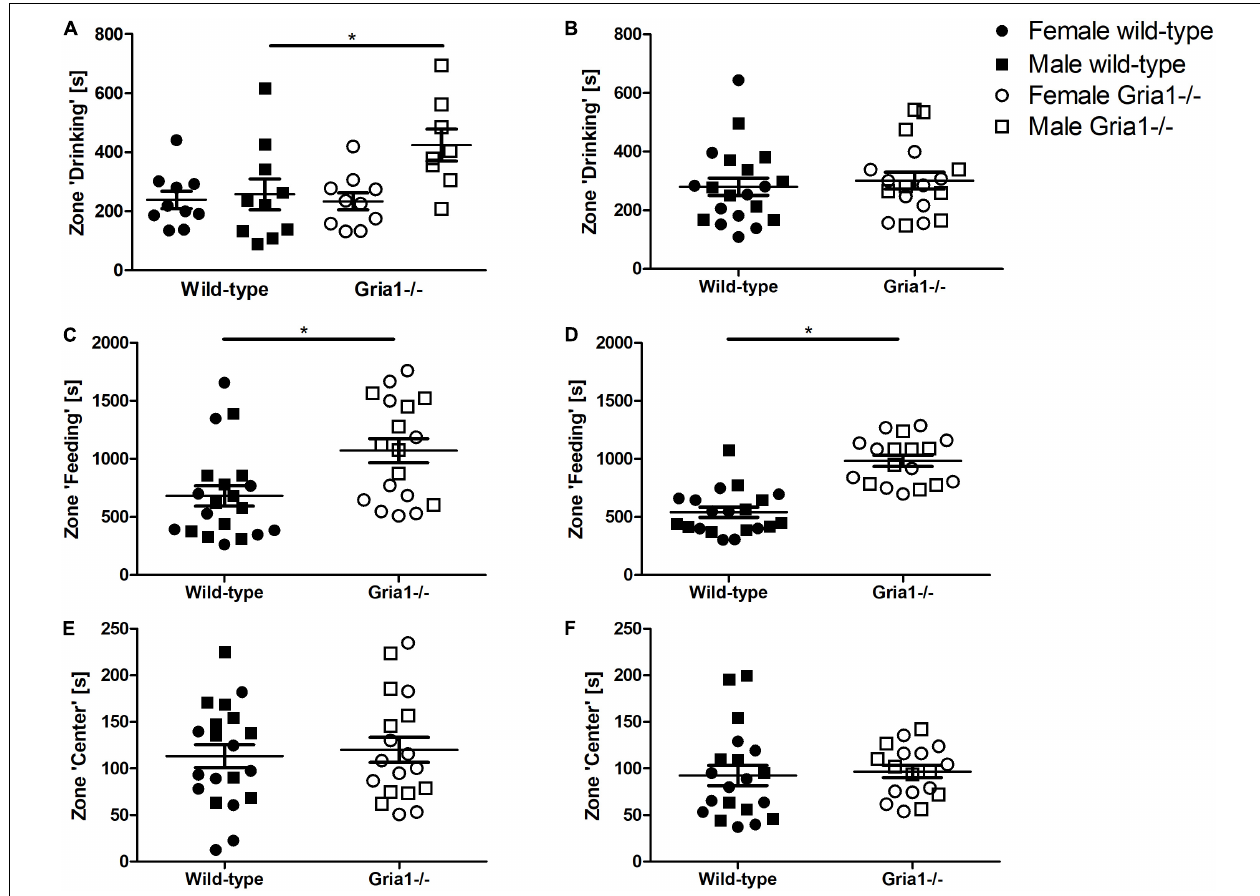
FIGURE 5 | Bench-top assessment focusing on cage zones. We analyzed home-cage based activities per zone, assessing the duration the animals spent in predefined areas of the home cage. Concerning the zone “drinking,” there was a significant effect of genotype and a relevant genotype by sex interaction in prepubescent mice (A) , showing that male Gria1 − / − mice spent more time in the zone “drinking” than age-matched male wild-types. In sexually mature mice (B) , we did not detect significant group differences for the time spent in the zone “drinking.” Prepubescent Gria1 − / − mice spent significantly more time in the zone “feeding” than age-matched wild-types (C) . This was also the case for sexually mature Gria1 − / − mice (D) . Considering the duration spent in the center of the cage, genotypes were statistically similar in prepubescent (E) and in sexually mature (F) mice. ANOVA, followed by FDR correction or Bonferroni multiple comparison post hoc tests. n = 8–10 per genotype per sex. * p < 0.05. Error bars indicate the standard error of the mean